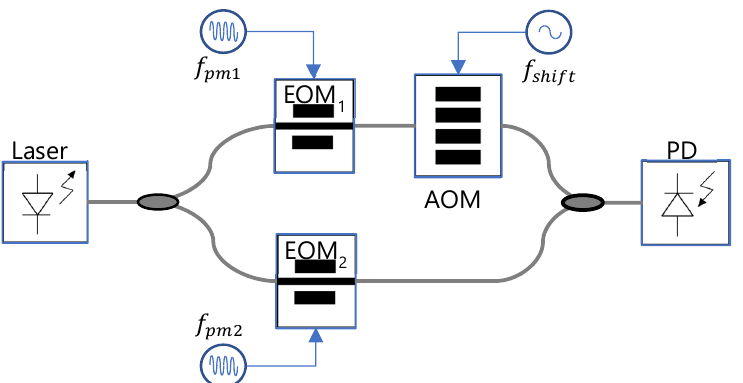
Figure 1. Basic scheme of an electro-optic dual optical frequency comb connected to a photodetector. EOM, electro-optic phase modulator; signal generators of EOM at frequencies f pm1 and f pm2 ; AOM, acousto-optic modulator; signal generator of AOM at frequency f shift ; PD, photodetector.